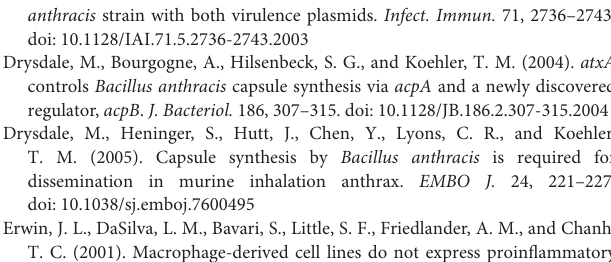
Supplementary Figure 1 | The deletion of pag gene promoter as indicated by PCR. Lane 1: DNA molecular marker. Lane 2: PasteurII, and Lane 3: PasteurII- pag